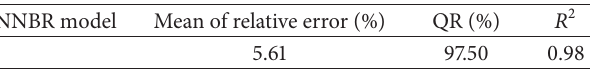
Table 2: Daily runoff prediction for 2008 of Hei River using NNBR